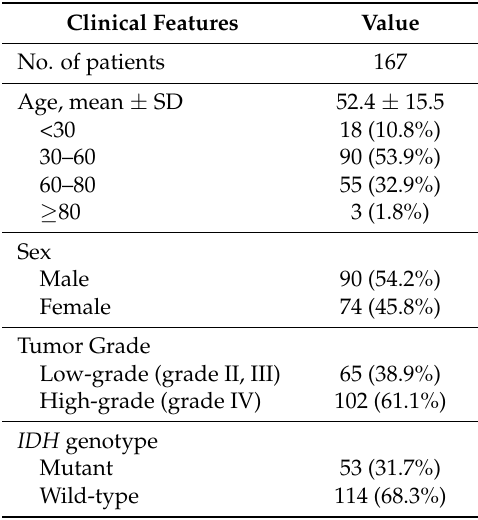
Table 1. Clinical characteristics of the